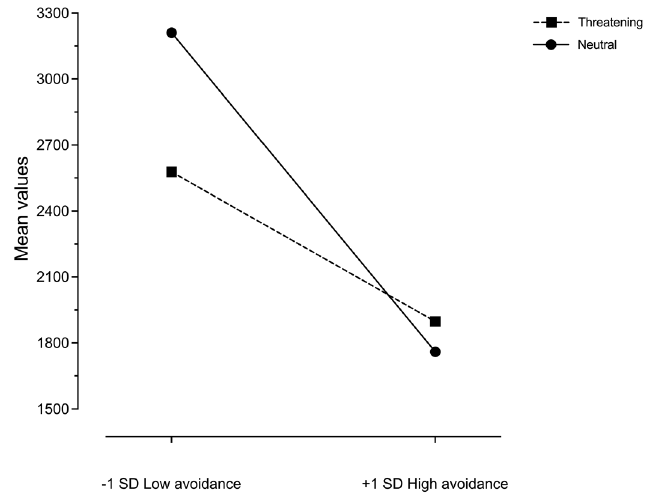
Figure 3. Means of care consistency RTs at − 1 SD and +1 SD of avoidance